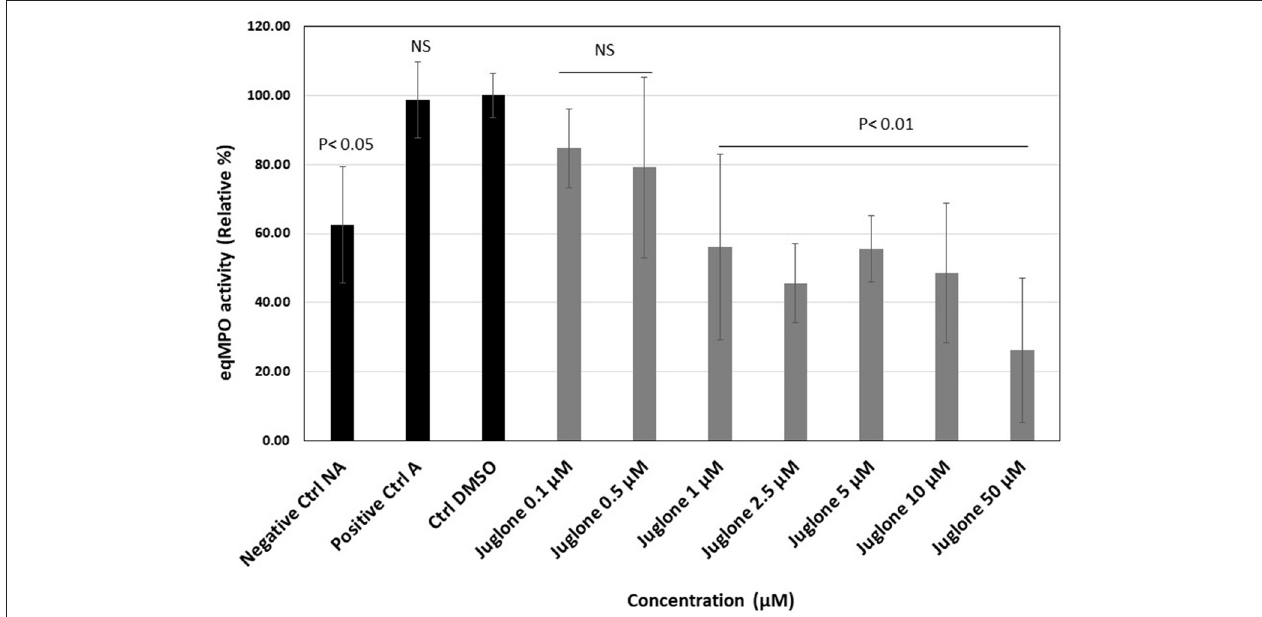
FIGURE 3 | Effect of juglone on the active myeloperoxidase (MPO) release during the degranulation of neutrophils in the absence or presence of increasing concentrations of juglone (from 0.1 to 50 µ M). Positive control (A) , activated neutrophils alone; Ctrl DMSO , control with 1% dimethyl sulfoxide (DMSO). The results are presented as the mean value ± SD of independent experimental conditions ( n = 6). The mean value obtained for the condition Ctrl DMSO was taken as 100%. p < 0.05 and p < 0.01 were considered as significant.